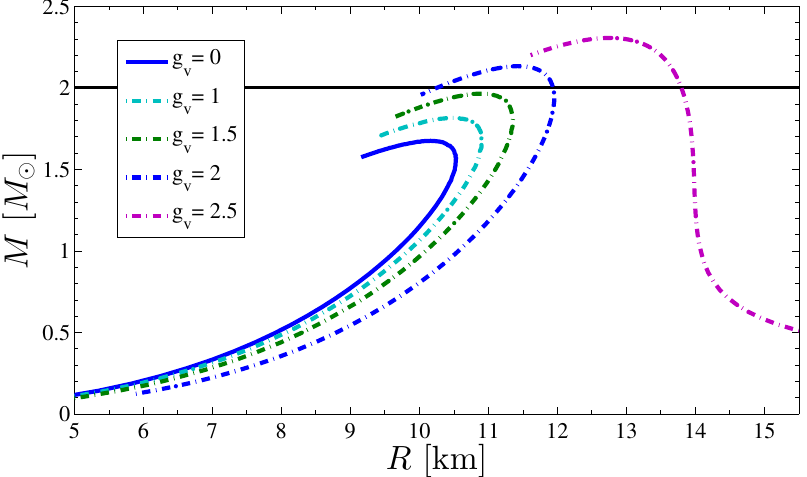
Figure 6. Dependence of the mass–radius relations on the strength of the Yukawa coupling g v between quarks and the vector meson in the eLSM